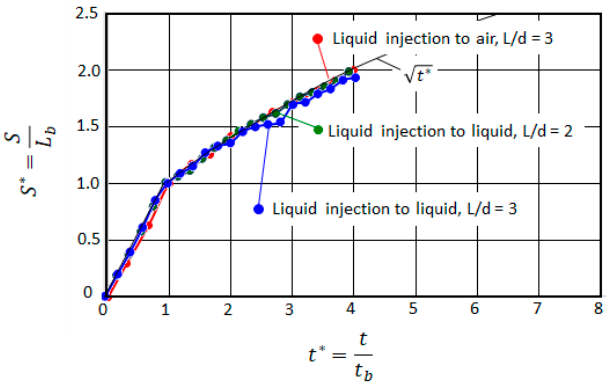
Figure 27. Spray tip penetration normalized by measured length and time of breakup.